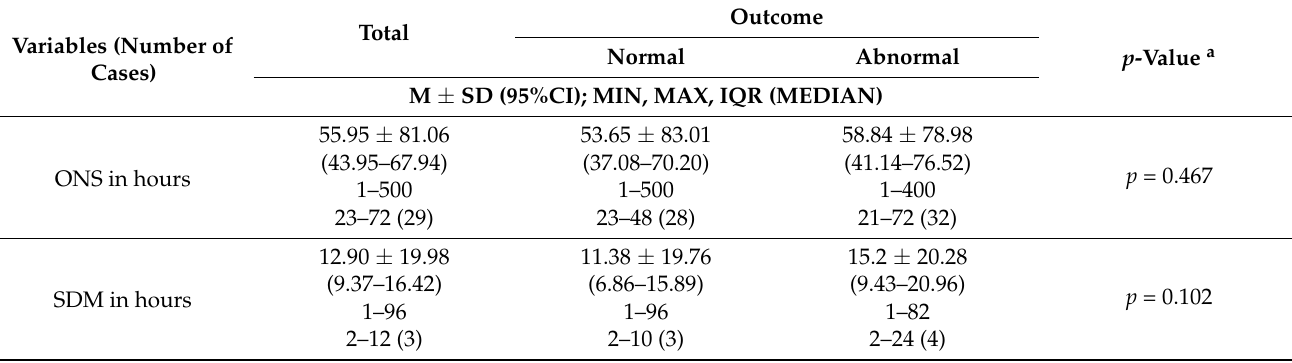
Table 4. Descriptive statistics for ONS and SDM variables in both normal and abnormal outcomes for the study